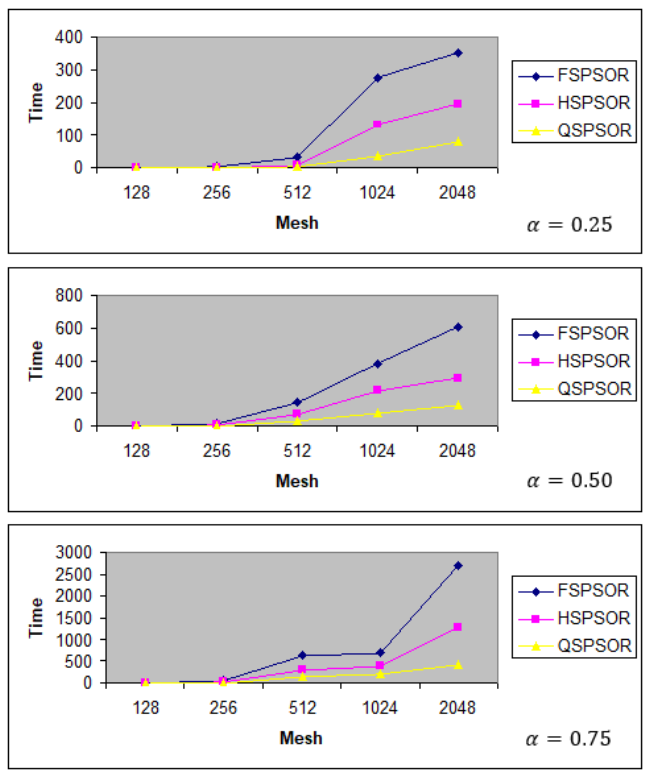
Figure 4. Graphs of performance of FSPSOR, HSPSOR, and QSPSOR methods to solve Example 2, showing mesh sizes versus execution time at three different fractional orders.